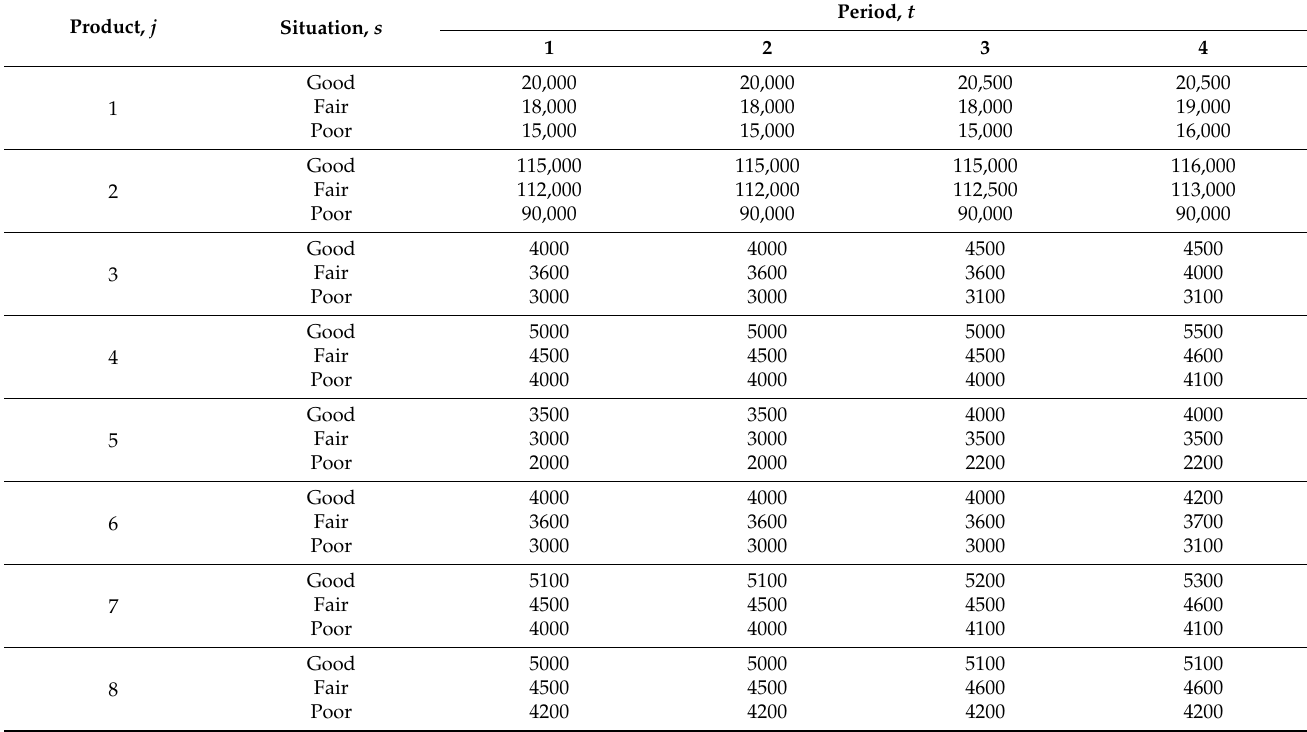
Table 10. Data for Market Demand (ton).